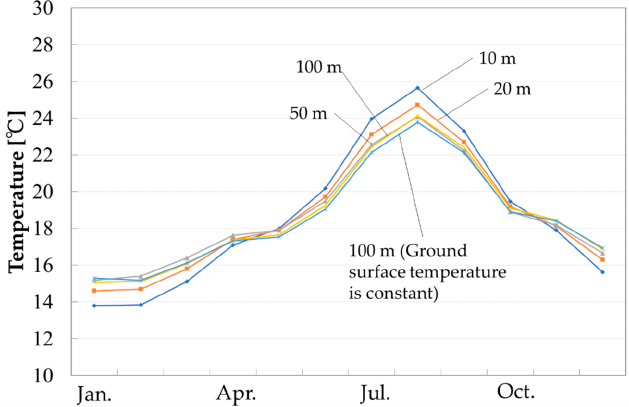
Figure 10. Monthly variations of the average surface temperature of GHE. (Effective thermal conductivity 1.5 W/m.K).